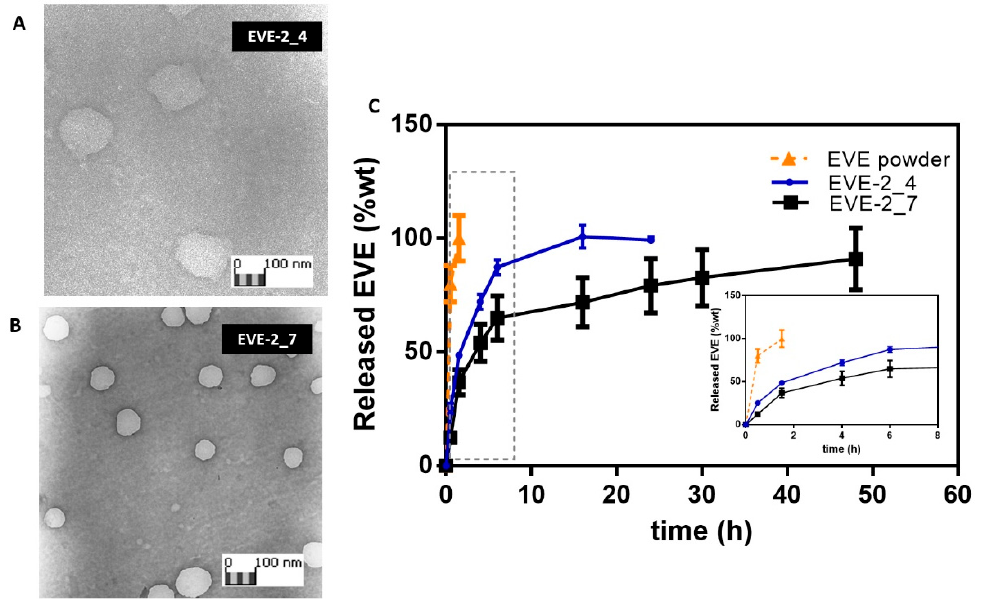
Figure 2. TEM images of EVE loaded HA/CS NPs, EVE-2_4 ( A ) and EVE-2_7 ( B ). ( C ) In vitro EVE release from EVE-2_4 (blue line) and EVE-2_7 (black line), 100 μ g of NPs was suspended in 0.01M PBS with 1% w / v Tween 20 pH 7.4. NPs release behavior is compared to EVE raw material dissolution profile (orange line). Insert: EVE release profiles between 0 and 8 h of incubation.